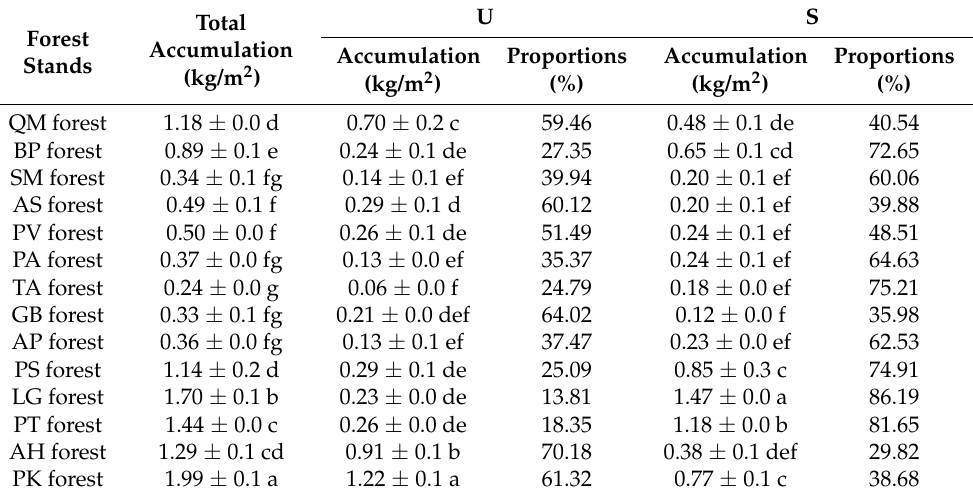
Table 3. Litter accumulation (mean ± SD) in different decomposition degrees. Note: Different lowercase letters indicate significant differences among tree species at the 0.05 level. U indicates un-decomposed layer and S indicates semi-decomposed layer. The abbreviation of tree species is the same as Table